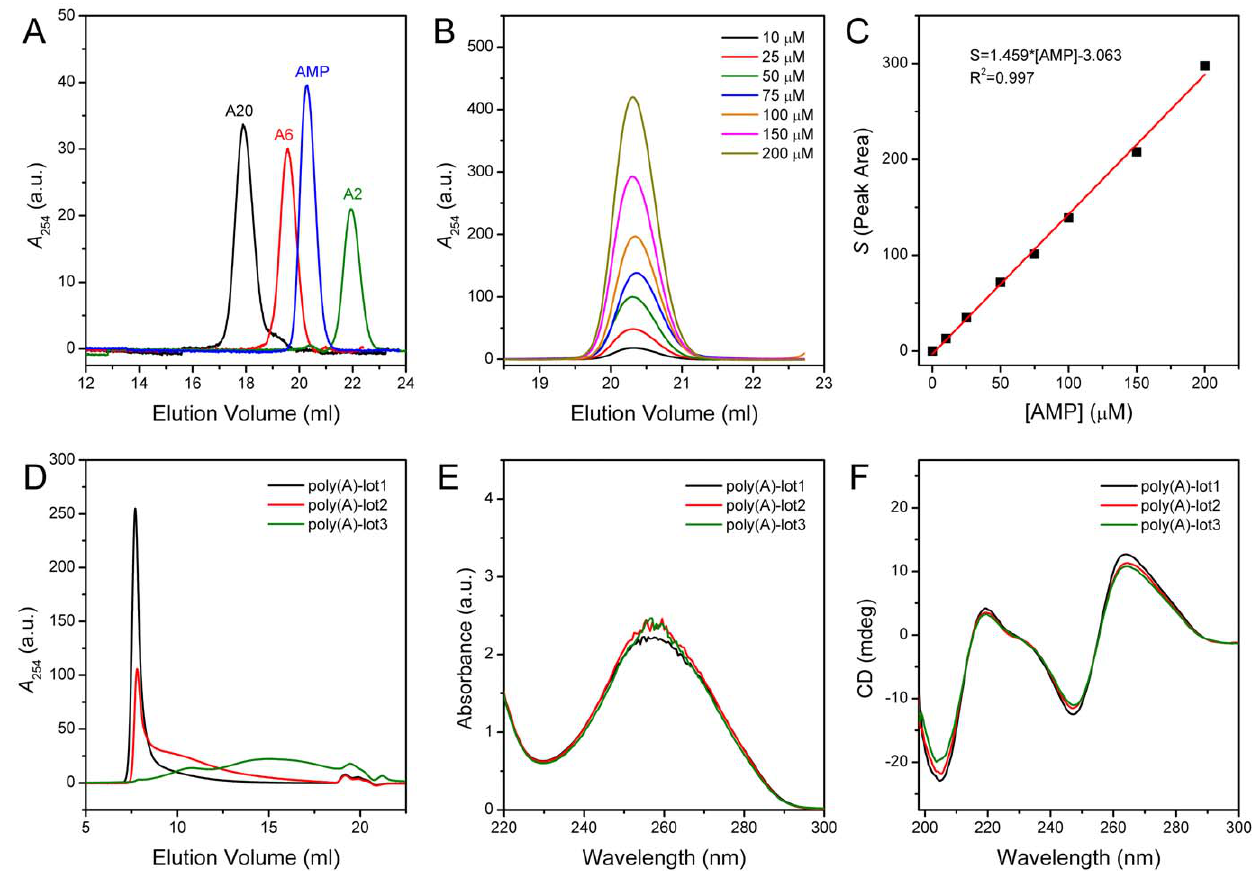
Figure 1. Characterization of the synthetic oligo(A) and commercial poly(A) samples. (A) SEC profiles of A20, A6, A2 and AMP. The concentration of A20, A6, A2 and AMP were 2, 5, 10 and 25 m M, respectively. (B) SEC profiles of AMP with various concentrations. (C) Relationship between the peak area of the AMP elution peak and the AMP concentration. The raw data is shown as square symbols and the fitted curve is presented as a solid line. (D) SEC profiles of three batches of commercial poly(A) samples with a mass concentration of 100 m g/ml. (E) UV absorption spectra of the three batches of commercial poly(A) samples with a concentration of 100 m g/ml. The UV absorption spectra were measured by Ultraspec 4300 pro UV/Visible spectrophotometer using a cell with a path length of 1 cm. (F) CD spectra of 100 m g/ml poly(A) samples. The CD spectra were recorded on a Jasco-715 spectrophotometer using a cell with a path length of 0.1 cm. All samples were prepared in buffer A. The SEC analysis was performed using a Superdex 200 10/30 GL column, and the absorbance at 254 nm was